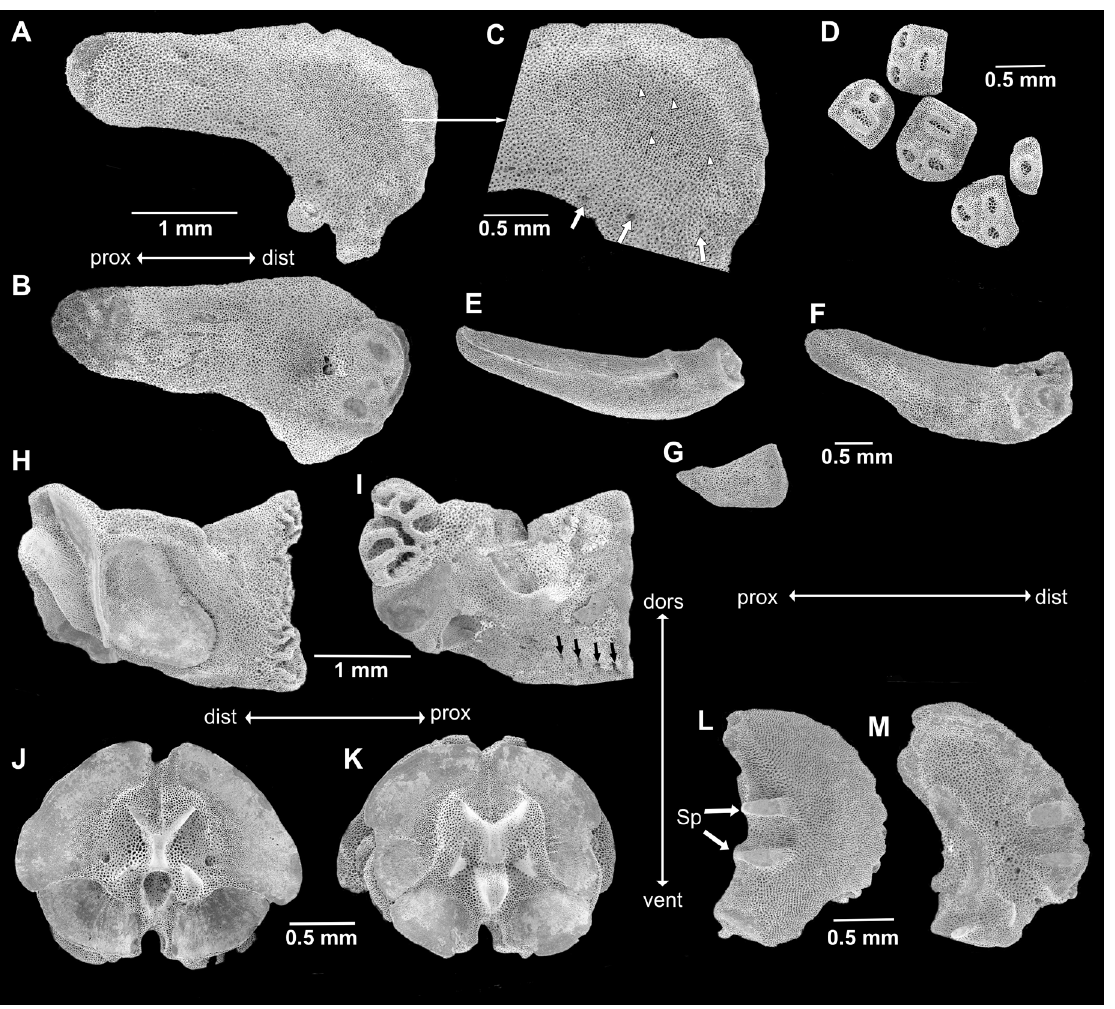
Fig. 8. SEM images of skeletal elements of Ophioderma africana sp. nov., from paratype of 15.7 mm disc diameter (SMNH-Type-7486). A . Radial shield, external aspect. B . Radial shield, internal aspect. C . Scale-free part magnified from Fig. 8A, white arrowheads point to granule sockets and pores, white arrows point to larger peripheral pores. D . Dental plate fragments. E – F . Adradial genital plate, two opposite lateral aspects. G . Abradial genital plate. H . Oral plate, abradial face. I . Oral plate, adradial face, black arrows point to oral papillae sockets and pores. J . Arm vertebra, proximal face. K . Arm vertebra, distal face. L . Lateral arm plate, external face. M . Lateral arm plate, internal face. Abbreviations: dist = distal; dors = dorsal; prox = proximal; Sp = spurs; vent =